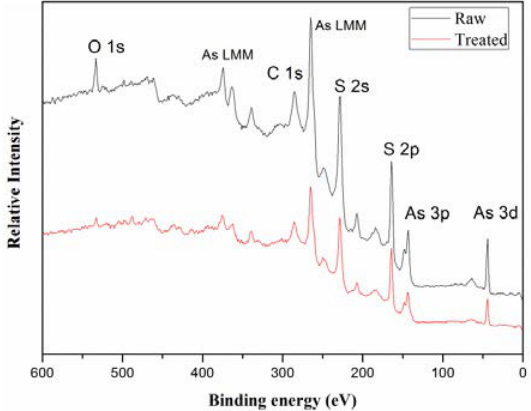
Figure 6. XPS spectra of the raw HB-ASR and that treated for 240 min using a high pass energy of 100 eV.